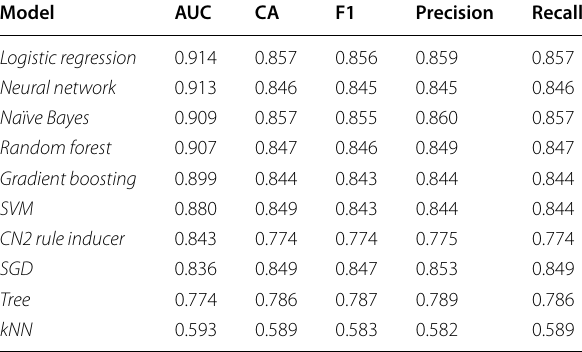
Table 3 Results of the secondary multivariate analysis focused on the ventilation modalities and the main outcome. In the table, listed are all the machine learning-tested models and their performances from the most performing to the least Model AUC CA F1